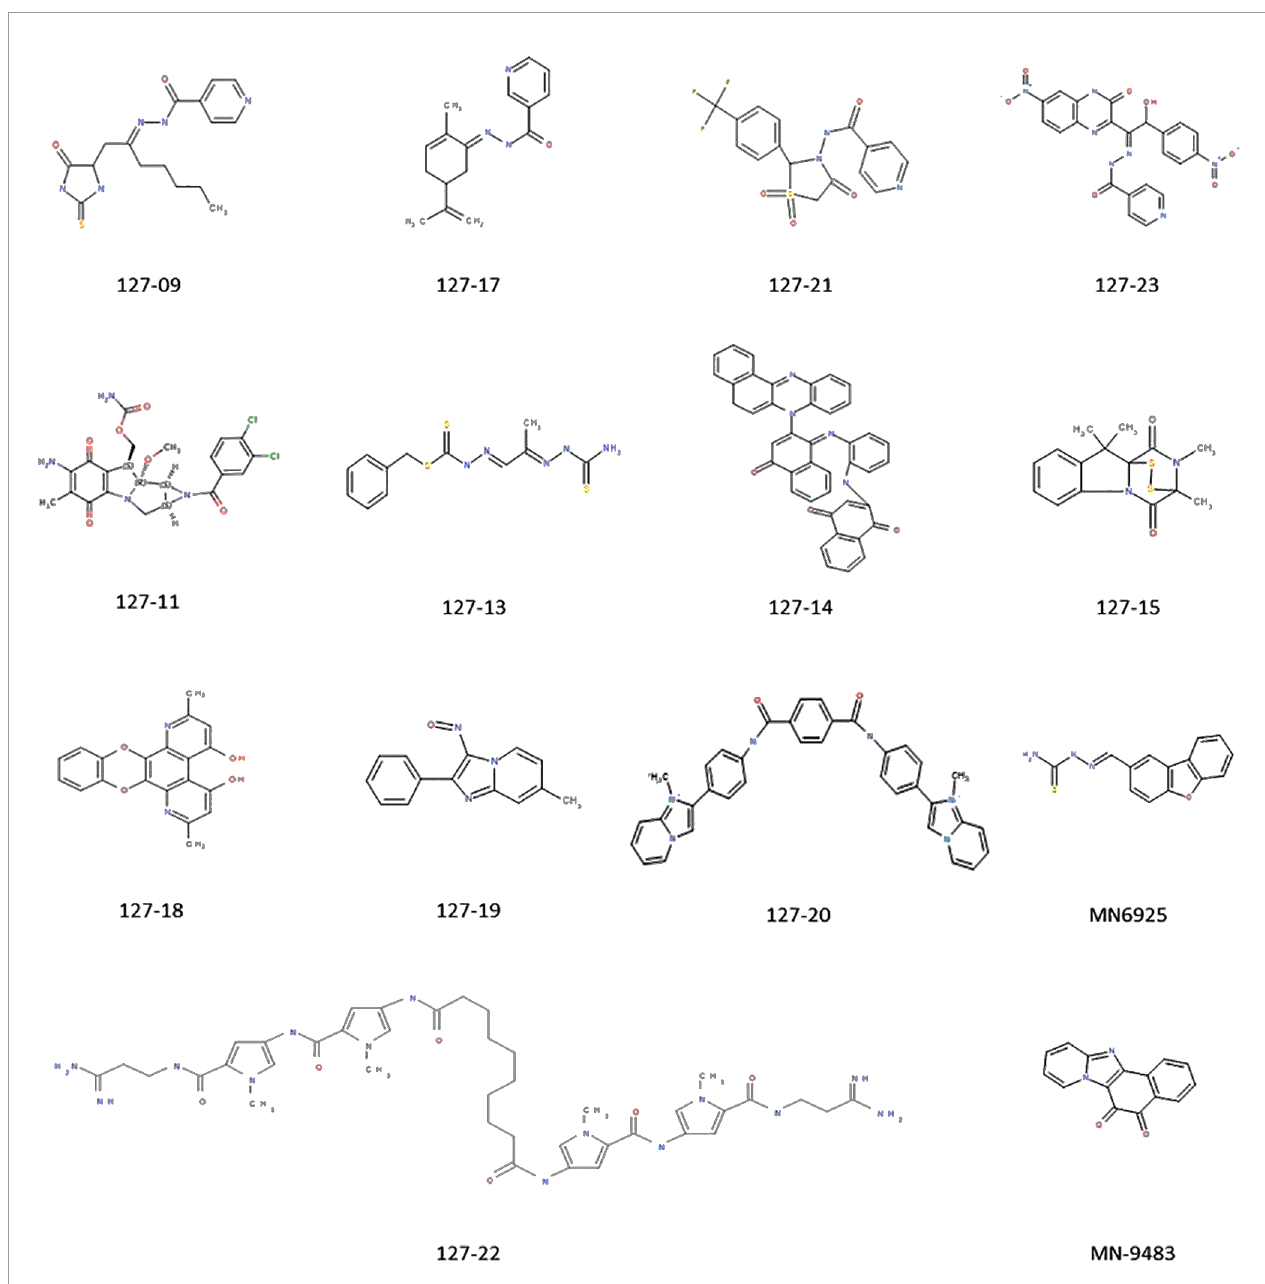
FIGURE 1 | Compounds exhibiting activity against